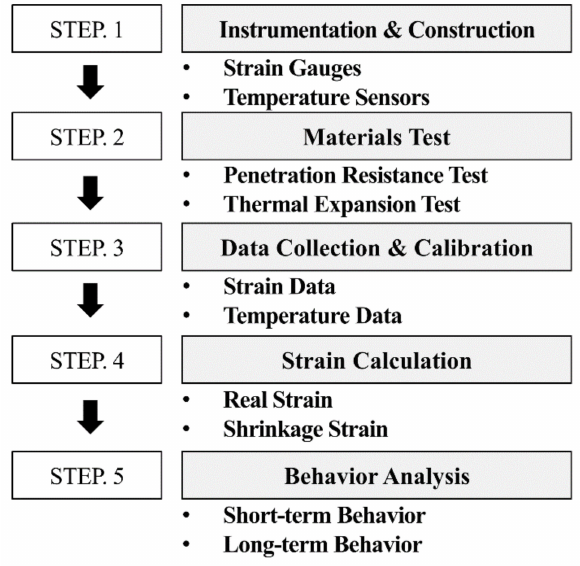
Figure 1. Flow chart of the